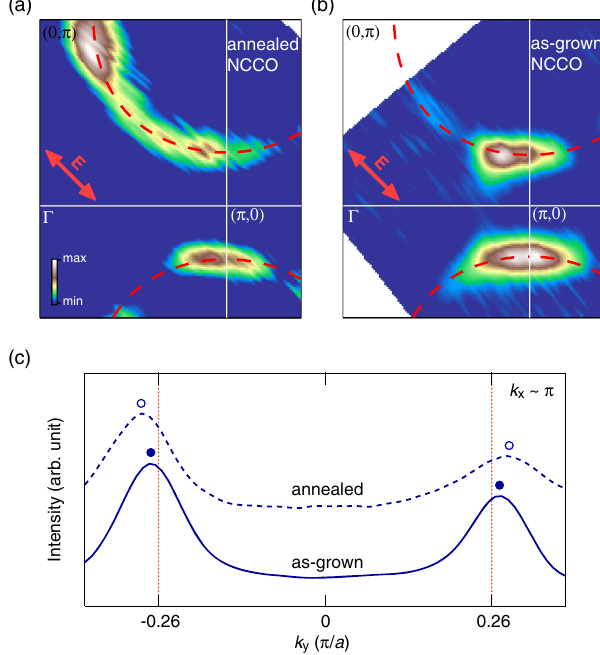
FIG. 3. Fermi surface topology in ARPES. We show Fermi surface intensity mappings for (a) annealed and (b) as-grown NCCO measured by ARPES at T ¼ 25 K with E Intensities are integrated within (cid:3) 10 meV of E F . Note that the mappings are not folded. The dashed red curves for the Fermi surface are guides to the eye. Red arrows indicate the polarization of incident x-ray (c) line cuts along the k y direction around ( π , 0). Here, k x is integrated over the range [ 0 . 95 π , 1 . 05 π ]. The open (filled) circles denote the nesting wave-vector positions of the annealed (as-grown) NCCO. The vertical lines indicate the in- plane wave vector measured by RSXS.